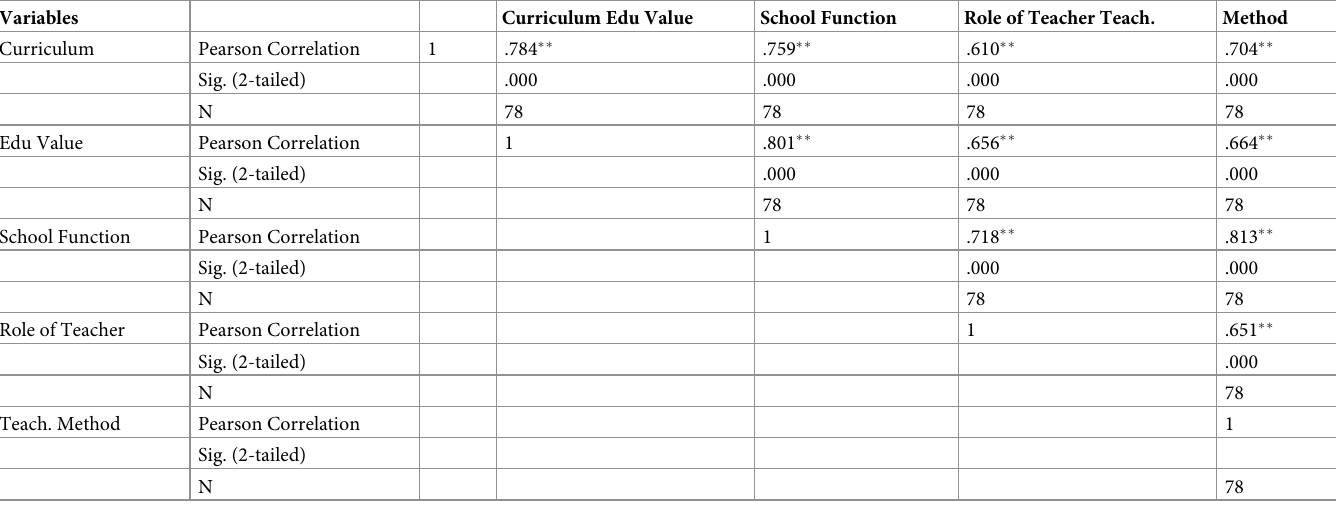
Table 14. Bivariate correlation analysis of the five categories. Variables